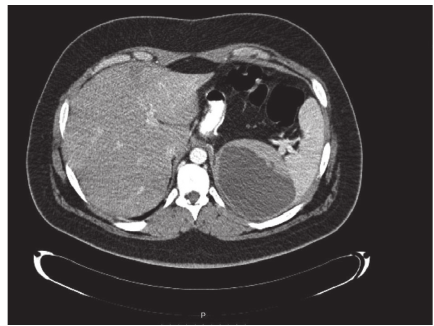
Figure 1: Splenic abscess of 10cm with no evidence of leakage.